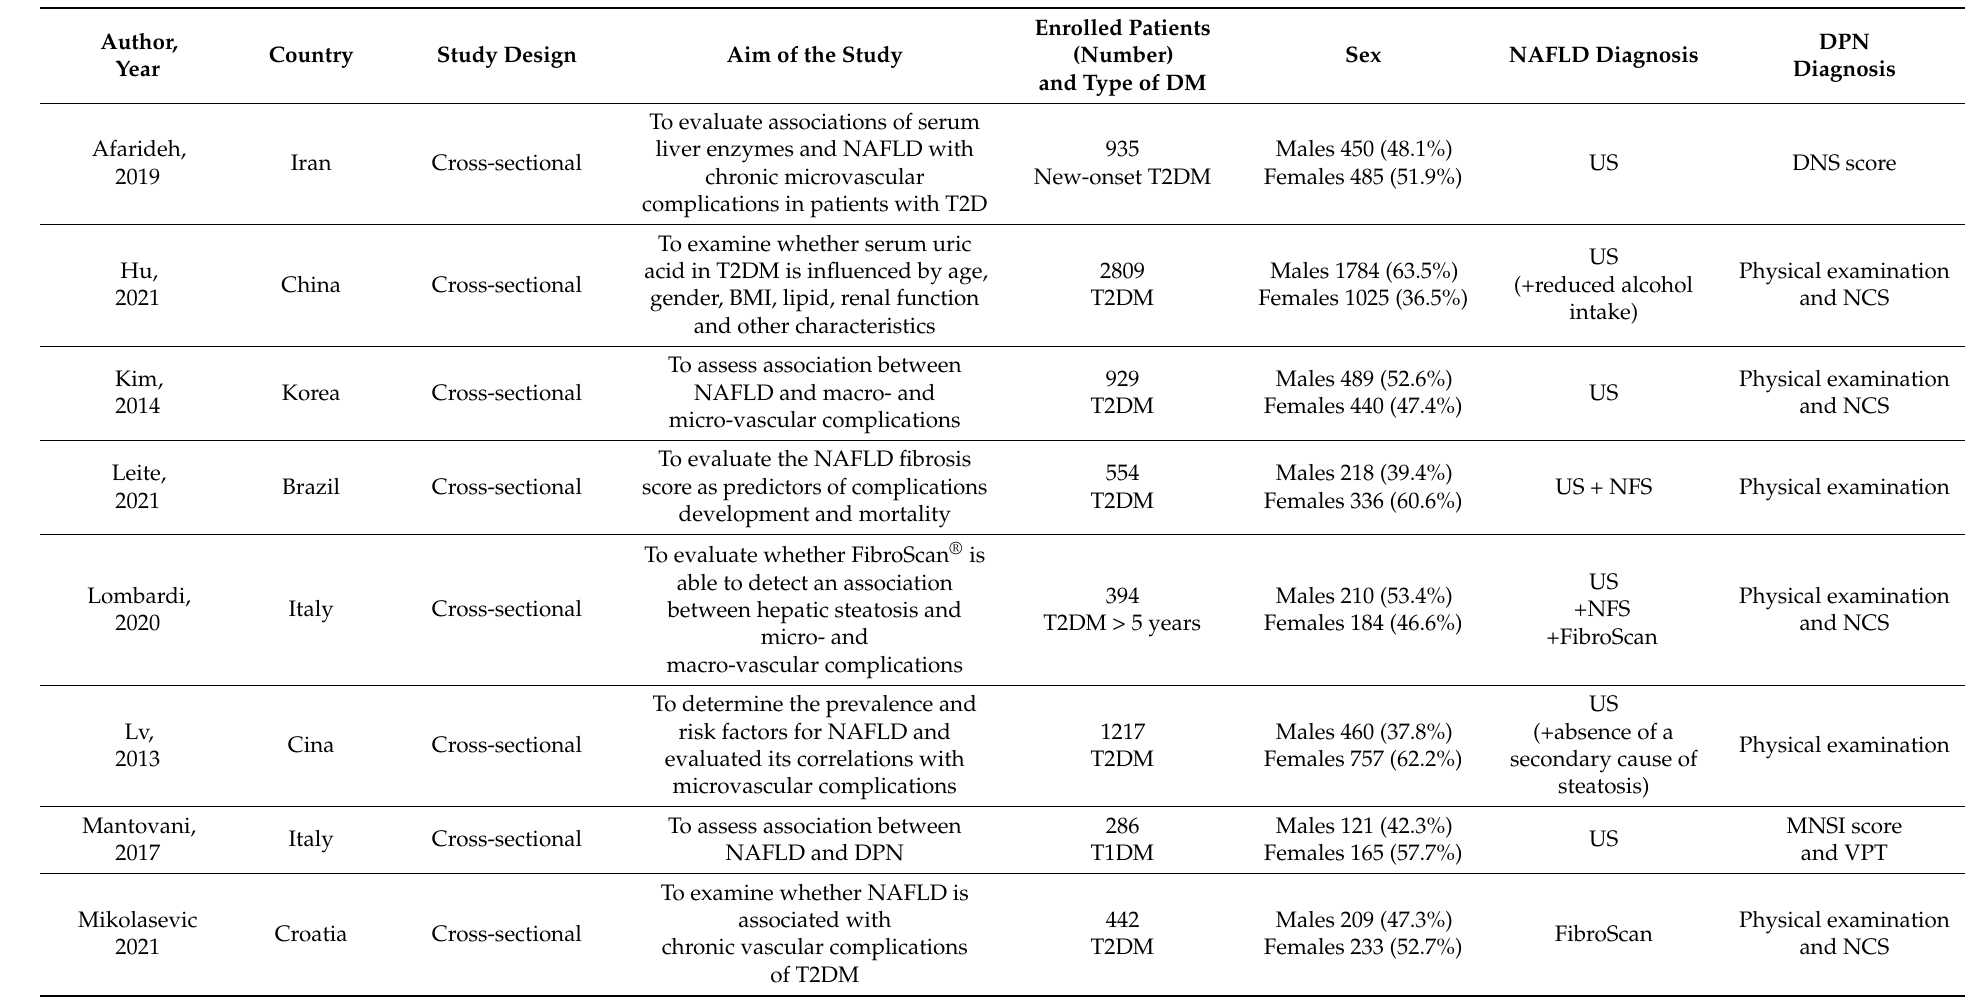
Table 1. Included studies’